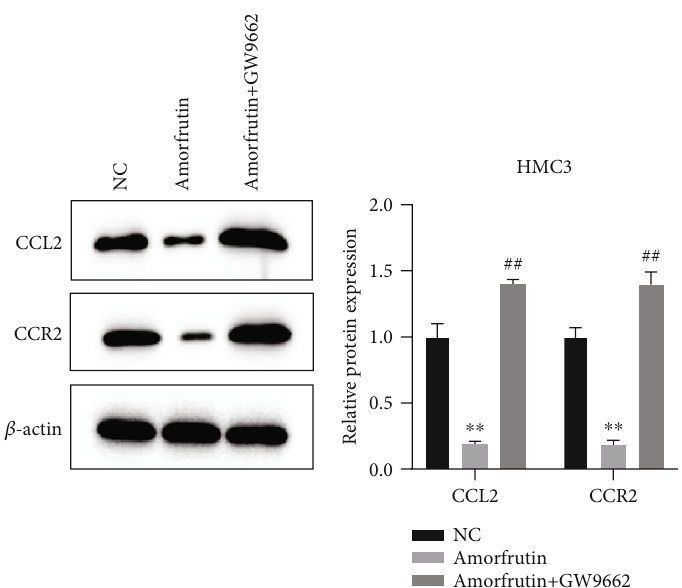
Figure 1: Amorfrutins suppressed the CCL2/CCR2 expression by activating PPAR γ . The CCL2 and CCR2 protein expressions were signi fi cantly decreased in the amorfrutin group, whereas the GW9662 reversed the e ff ects induced by amorfrutins.